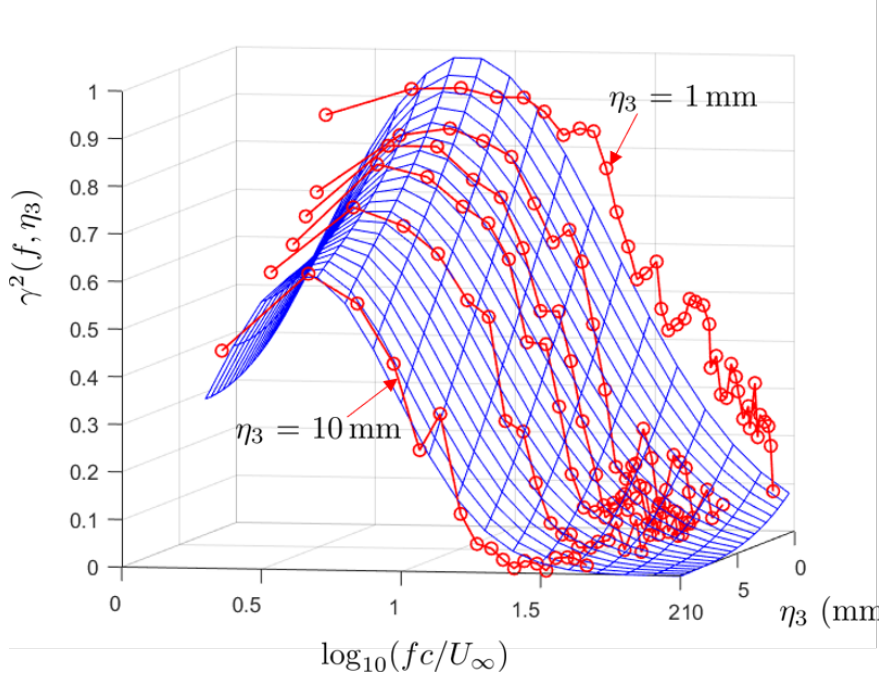
Figure 15. Fit of the coherence plot with a log-normal distribution. Same data as in Figure